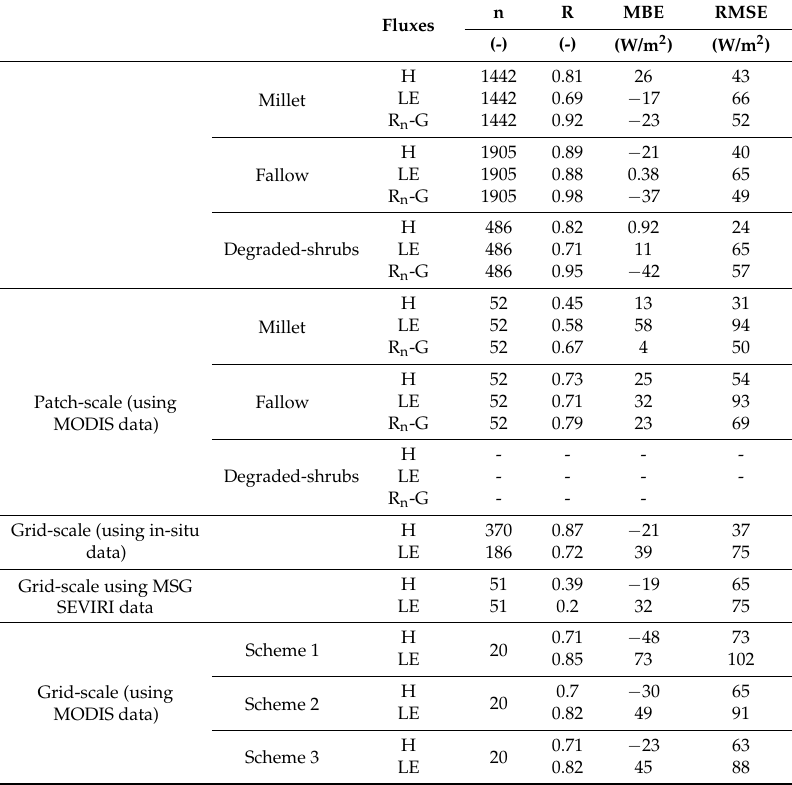
Table 3. Statistical metrics of the comparison between measured and estimated values of available energy and turbulent fluxes (H and LE) at patch and grid